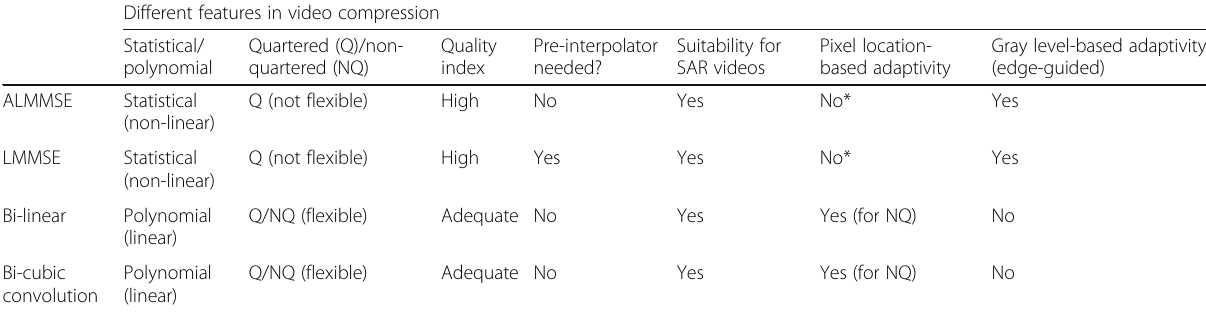
Table 1 Qualitative descriptions of the interpolation methods Different features in video compression Statistical/ Quartered (Q)/non- Quality polynomial quartered (NQ)